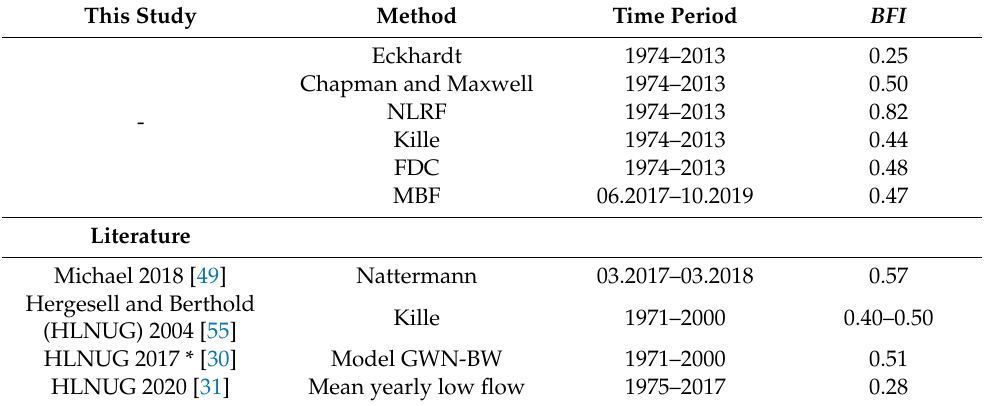
Table 3. BFI as determined by all applied baseflow separation methods as well as literature findings.